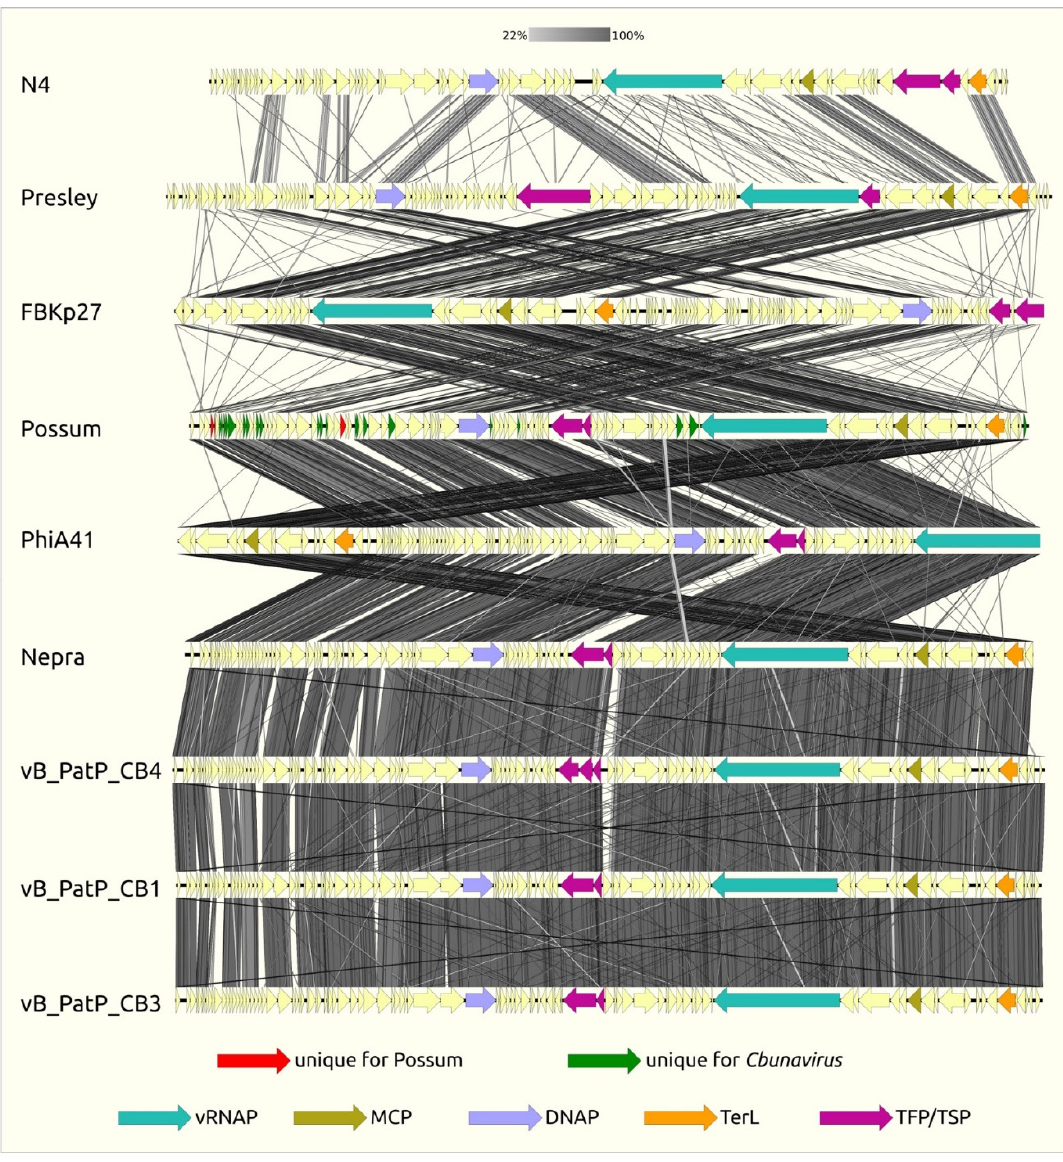
Figure 3. Genome sequence comparison among nine Schitoviridae genomes exhibiting co-linearity detected by TBLASTX. The percentage of sequence similarity is indicated by the intensity of the gray color. Vertical blocks between analyzed sequences indicate regions with at least 22% similarity. Genes’ names are as follows: vRNAP, virion RNA polymerase; MCP, major capsid protein; DNAP, DNA polymerase; TerL, large subunit of terminase; TFP/TSP, tail fiber/tail spike